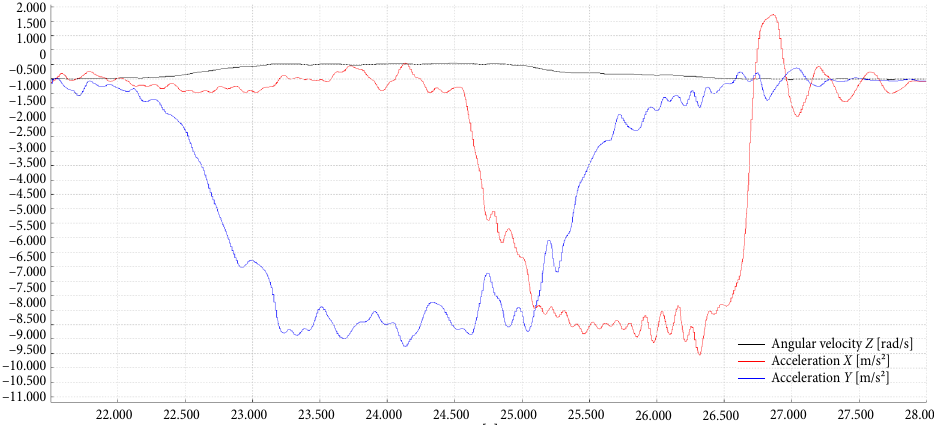
Fig. 2. Driving and braking of the Volvo V40 T5 AWD Cross Country vehicle in the curve of 30 m radius with the entering speed of 59 km/h, and speed at the beginning of braking reaching 57 km/h, DSTC sports mode (Exper. No 25) (Panáček 2015)